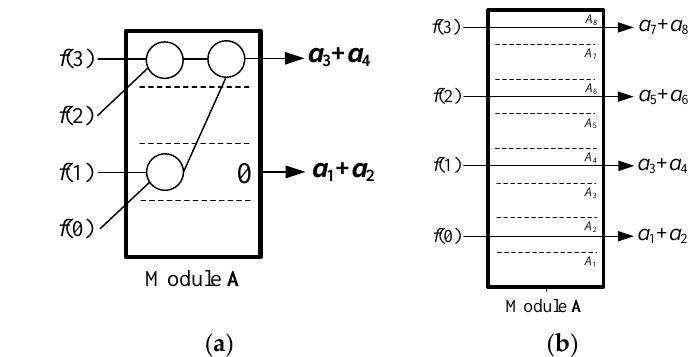
Figure 8. The module A for { g ( i ) } = {2, 1, 4, 2}.